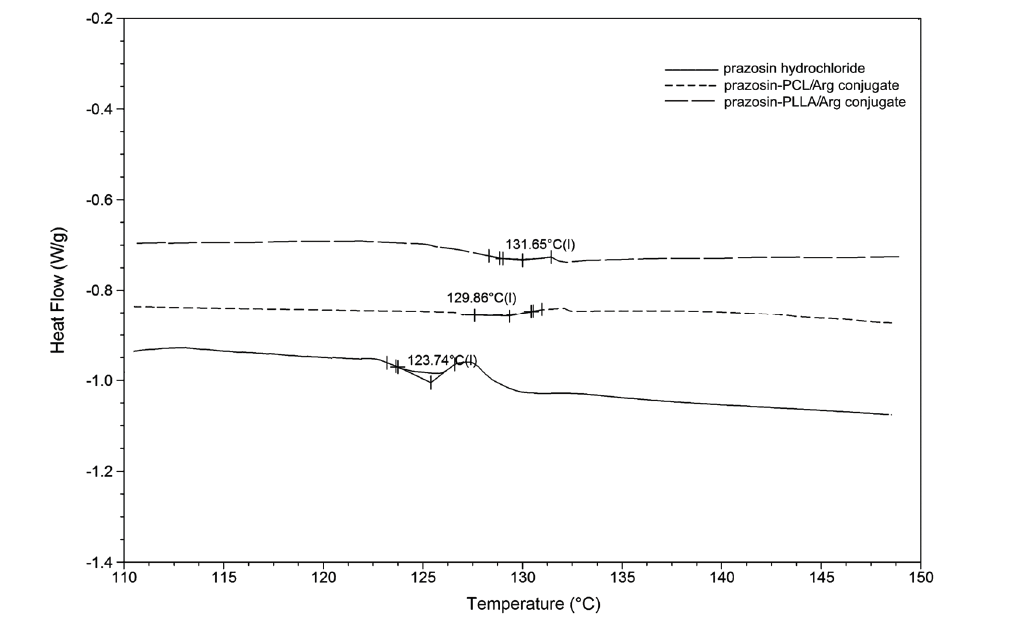
Figure 8. MDSC thermogram of a pure prazosin hydrochloride and synthesized macromolecular conjugates of